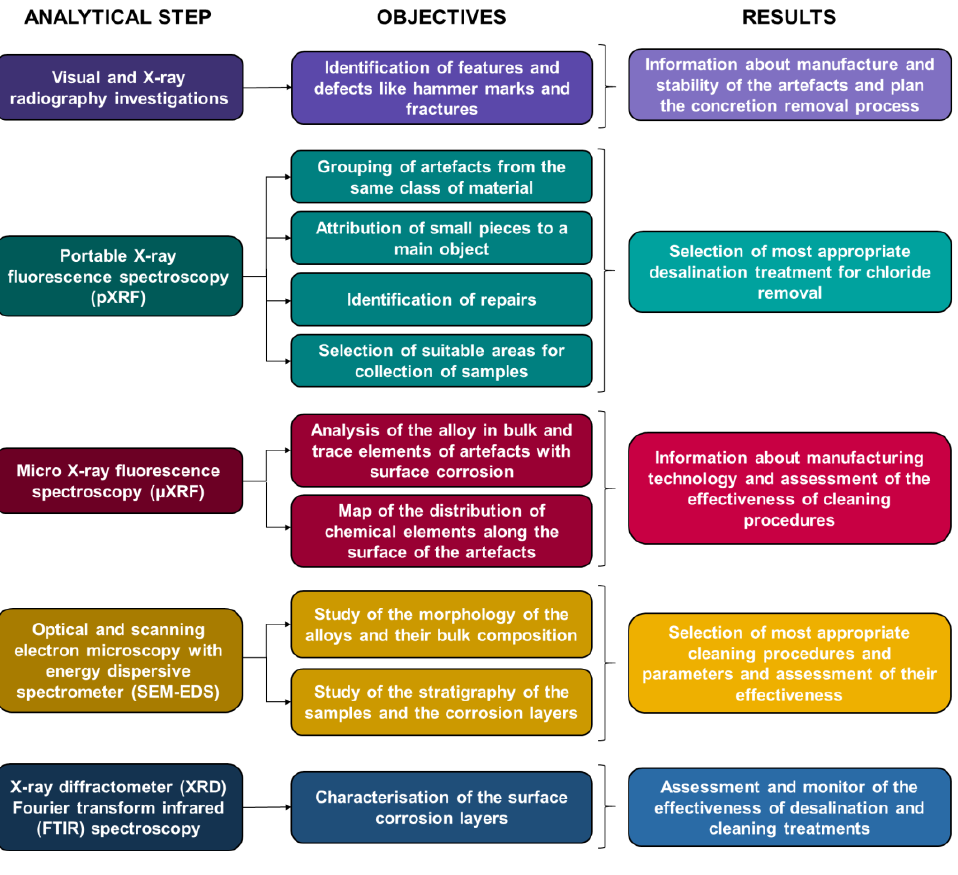
Figure 1. Multi-analytical protocol in use at FCL for the examination of copper alloy artefacts from marine sites.